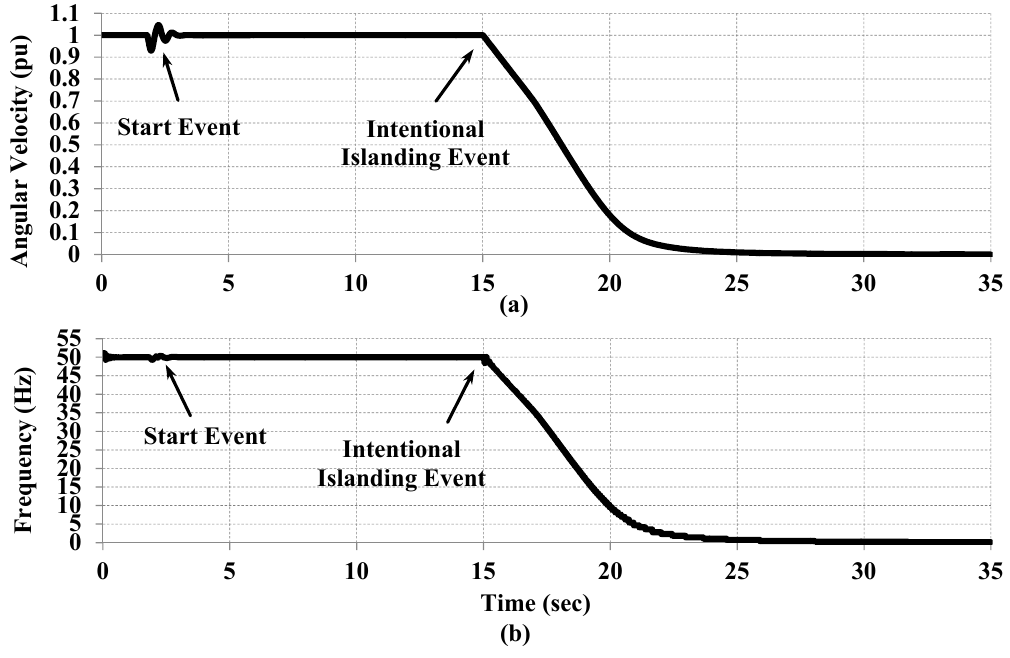
Figure 11. System parameters ( a ) synchronous generator angular velocity, ( b ) island-2 frequency.